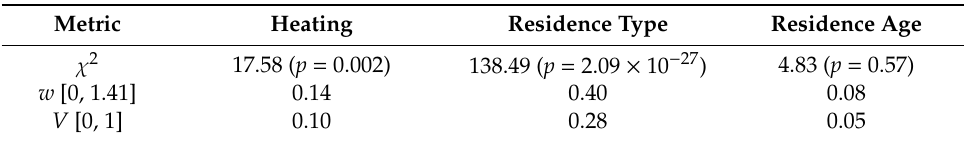
Table 5. Results of the association test between heating, residence type, and residence age and cluster composition.